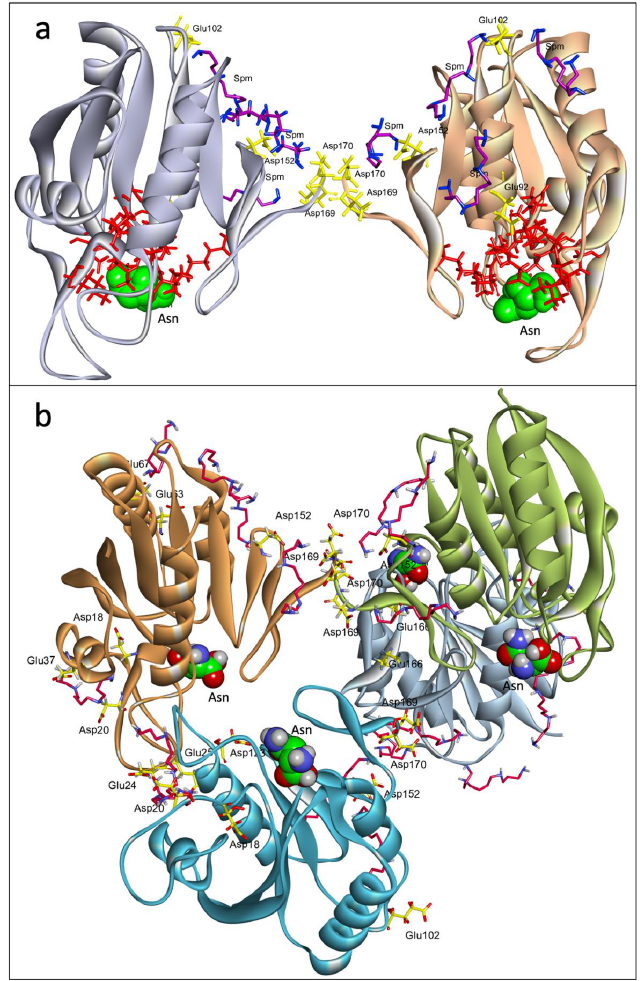
Figure 5. Results of docking: ( a ) dimer RrA with spermine and L-Asparagine; ( b ) tetramer RrA with spermine and L-Asparagine. Structure of L-asparaginase Rhodospirillum rubrum imported from website https://www.uniprot.org (Q2RMX1, accessed on 9 December 2022). Asp and Glu residues are highlighted in yellow, spermine molecules are highlighted in lilac, substrate L-asparagine is highlighted in green (atomic balls), and residues included in the enzyme active center are high- lighted in red.